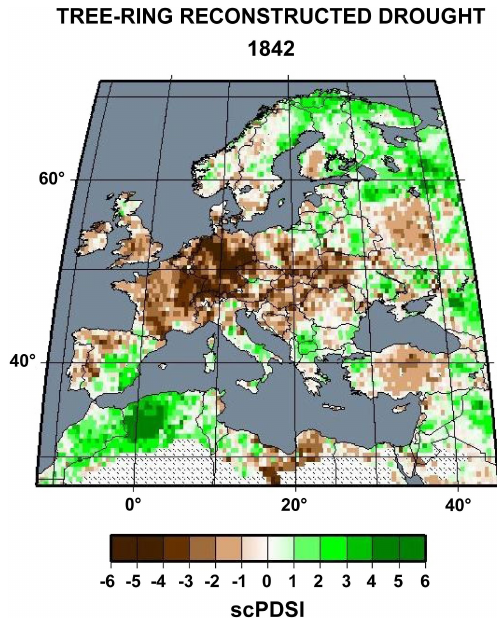
Figure 10. Values of summer scPDSI for 1842 in the European area as derived from tree rings in OWDA (Cook et al., 2015).